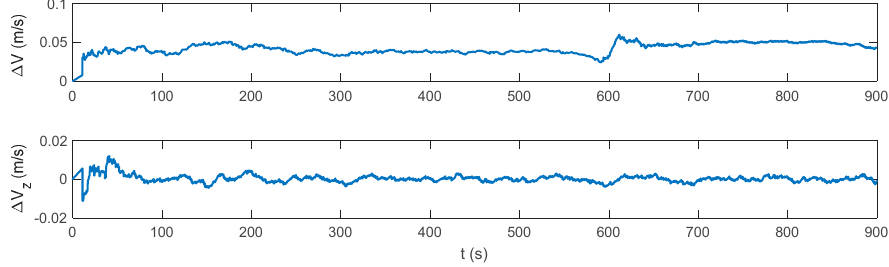
Figure 4. Velocity error of the INS/DVL-integrated navigation system.